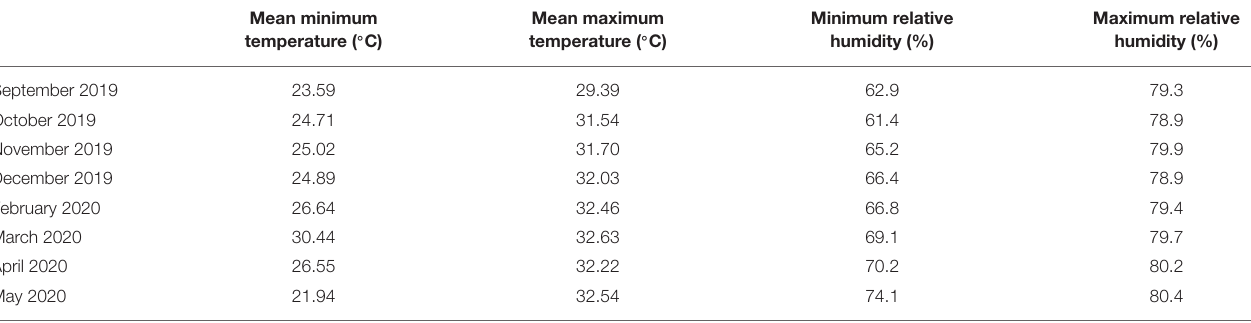
TABLE 1 | Mean values of temperature and relative humidity in the greenhouse during the experimental period.